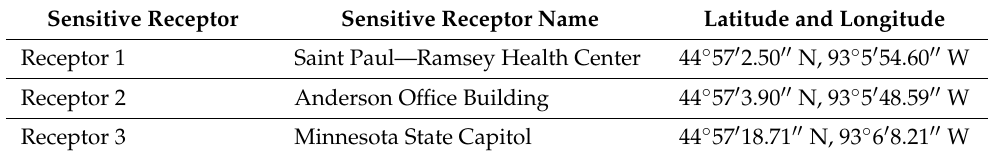
Table 3. Assessed Sensitive Receptor Locations.